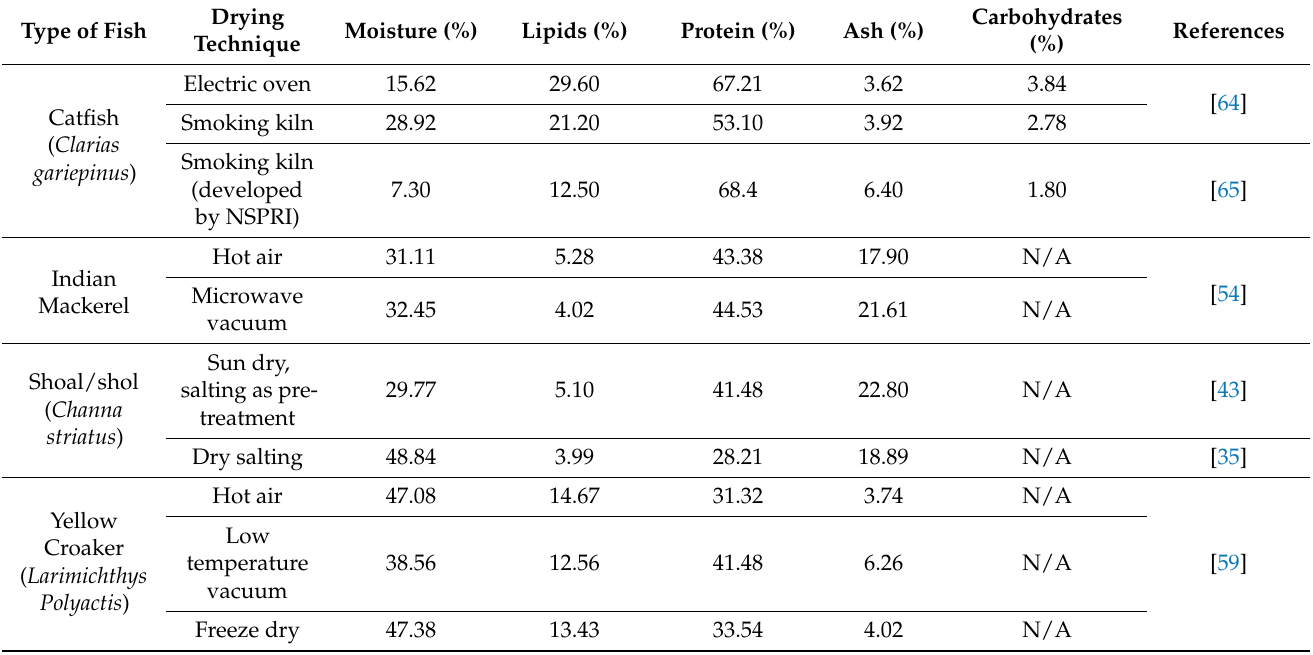
Table 1. Proximate composition of various fish species and its respective drying